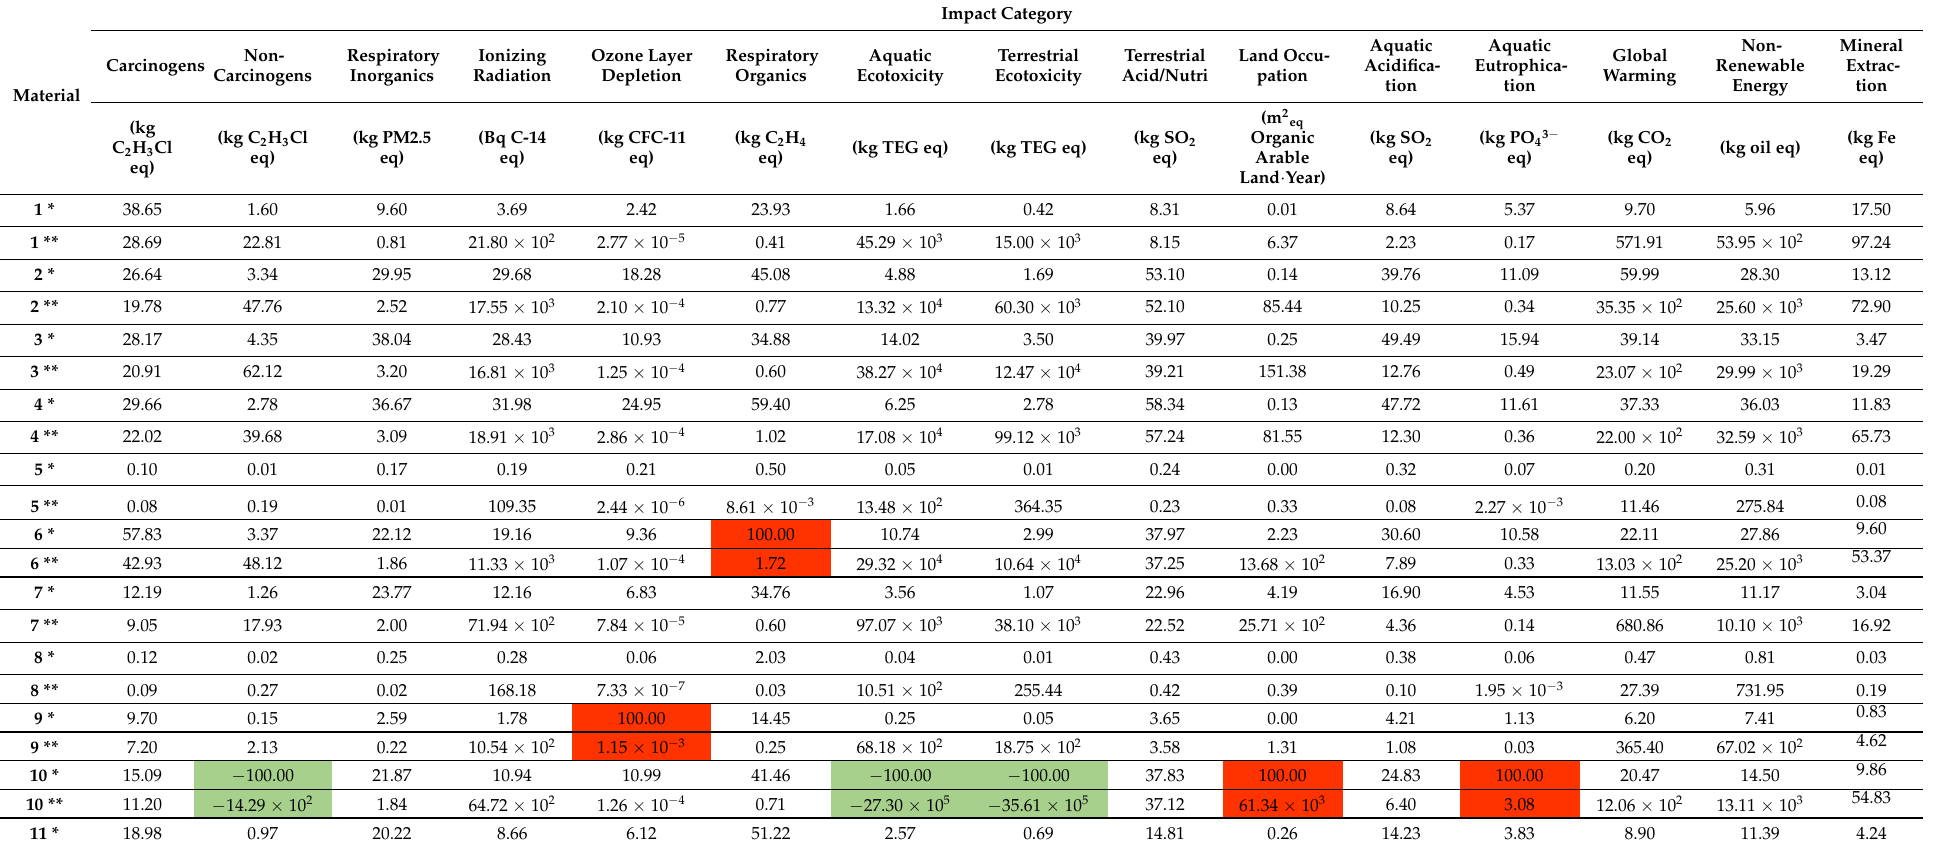
Table A1. Midpoint characterization environmental impacts of the SBRB. Columns represent specific impact categories and lines refer to construction material listed in Table 4. Contribution of particular construction material within each impact category is given in a relative percentage according to the material with the highest/lowest environmental impact marked in color. Red color symbolizes the highest environmental impact within the selected impact category and green color stands for the lowest environmental impact. In addition, actual contributions according to the particular impact category units are placed right below the lines with percentage